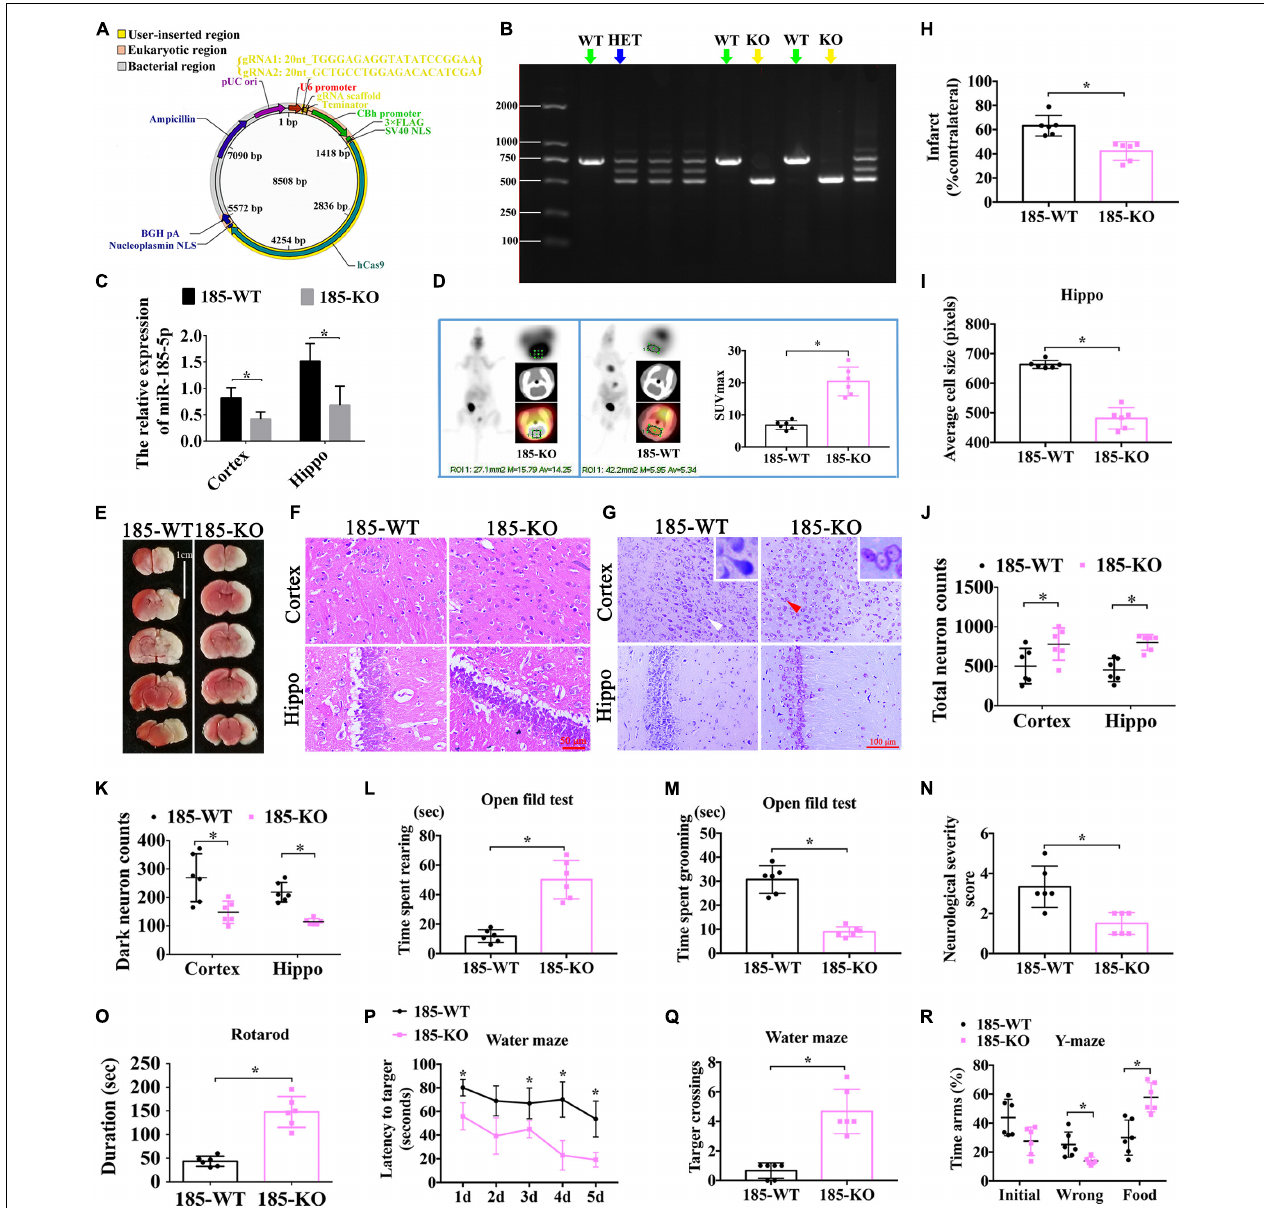
FIGURE 5 | The role of miR-185-5p KO in the improvement of neurological function after HIE. (A) The vector map for miR-185-5p vector builder. U6 promoter: Human U6 promoter. {gRNA1: 20nt_TGGGAGAGGTATATCCGGAA; gRNA2: 20nt_GCTGCCTGGAGACACATCGA}: the component entered by user. gRNA scaffold, Chimeric gRNA scaffold; Terminator, U6 terminator; CBh promoter, Chicken beta Act n hybrid promoter; 3xFLAG, 3 tandem flag epitopes; SV40 NLS, SV40 nuclear localization signal; hCas9, Human codon-optimized Cas9; Nucleoplasmin NLS, Nucleoplasmin nuclear localization signal; BGH pA, Bovine growth hormone polyadenylation; Ampicillin, Ampicillin resistance gene; pUCori, pUC origin of replication. (B) Electrophoretic band chart for genotype detection. Green arrows represent WT rats, yellow represent KO, and blue arrow represents HET. The markers exhibit 100 bp, 250 bp, 500 bp, 750 bp, 1000 bp, and 2000 bp, respectively. (C) The relative expression of Igfbp3 in the rats of 185-WT and 185-KO. The relative expression was relative to that of the 185-WT in cortex group. (D) The glucose-uptake images in the brain and SUV max detected by PET-CT 2-month post HIE. (E,H) TTC staining and quantitative analysis of infarct ratio, respectively, in the rats of 185-WT and 185-KO. Scale bar = 1 cm. Pale color represents infarct area, n = 6/group. (F,I) HE staining and the cell size analysis of cortex and hippocampus, respectively, in the rats of 185-WT and 185-KO. Scale bar = 50 µ m, n = 6/group. (G) Nissl staining in cortex and hippocampus between 185-WT and 185-KO groups. The white arrow represents surviving neurons. The red arrow represents dark neurons. Scale bar = 100 µ m. (J,K) Quantitative histogram for total neuron and dark neuron in cortex and hippo in these groups, n = 6/group. (L,M) The time spent rearing and grooming in the open field test 1 month after HIE, respectively, n = 6/group. (N) NSS score at 1 month after HIE. (O) The duration of on the rotarod bar 1 month after HIE, n = 6/group. (P) The latency to target for the first 5 days training in the MWM test, n = 6/group. (Q) Target crossings in MWM test in the 6th day of testing. (R) The time spent in the initial, wrong and food arms of Y-maze at 1-month post HIE, n = 6/group. HET: heterozygote. 185-WT: miR-185-5p wild type. 185-KO: miR-185-5p knockout. PET-CT, Positron Emission Tomography-Computed Tomography; SUV, standardized uptake value; HE, hematoxylin-eosin; Hippo, hippocampus. All data are presented as mean ± SD, * P <